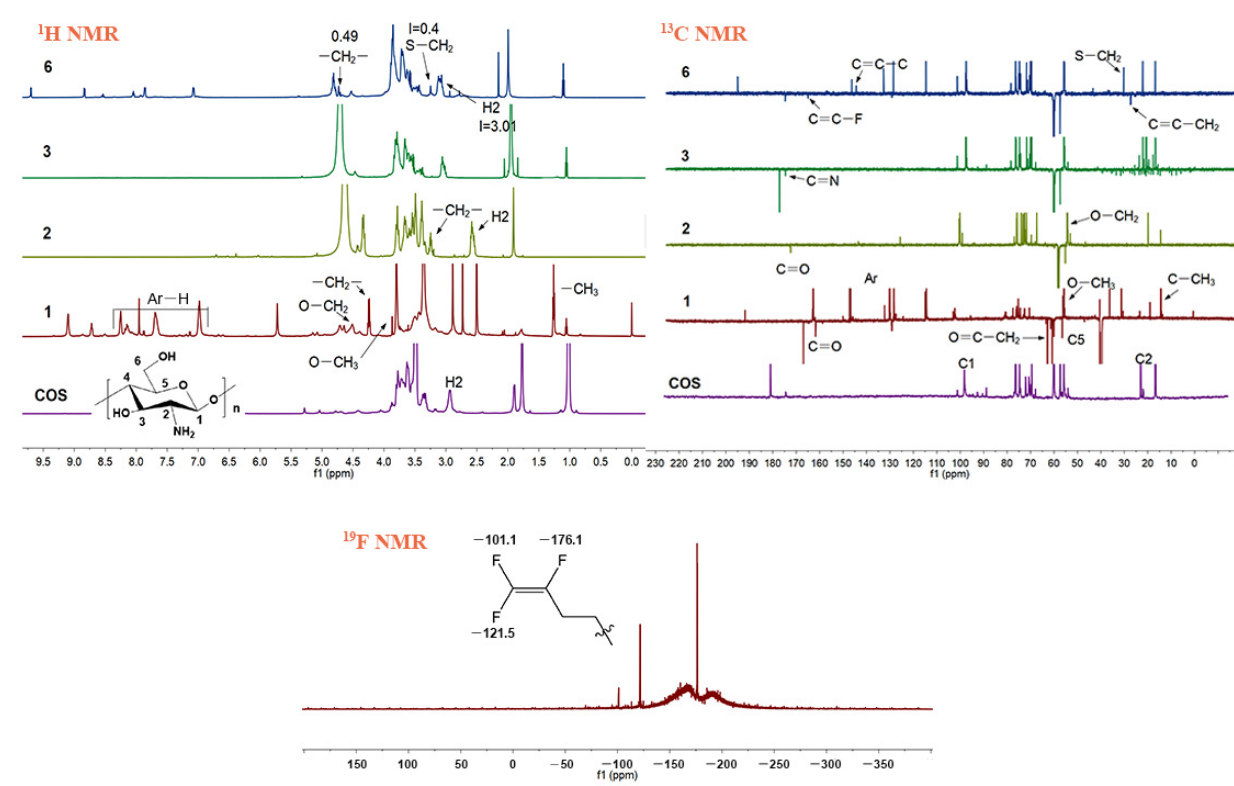
Figure 1. FTIR spectra of fluoroalkenyl COS derivative.